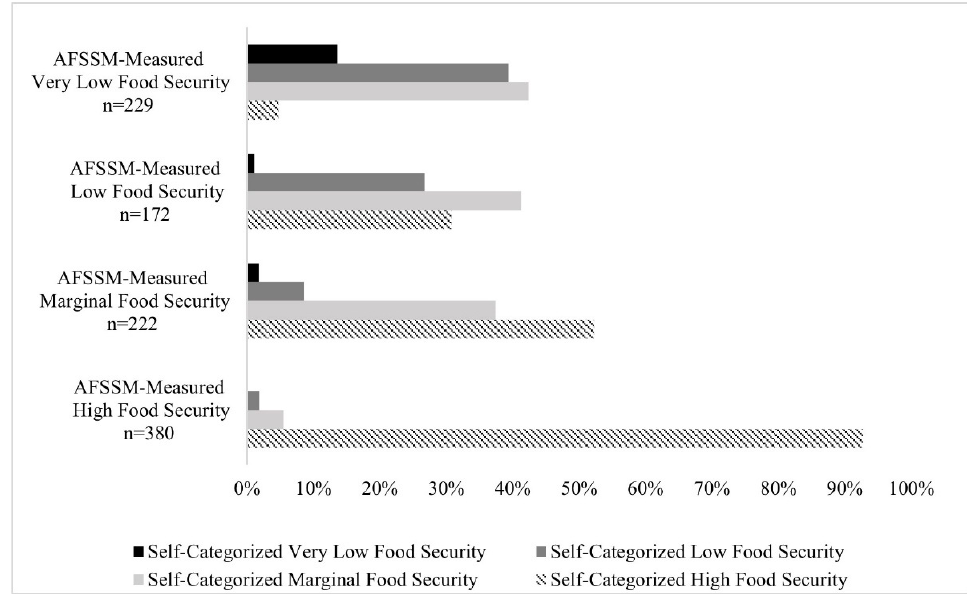
Figure 1. Self-Categorized Food Security Status and USDA AFSSM-Measured Food Security Status among College Students (n = 1003). USDA AFSSM = US Department of Agriculture 10-item Adult Food Security Survey Module.